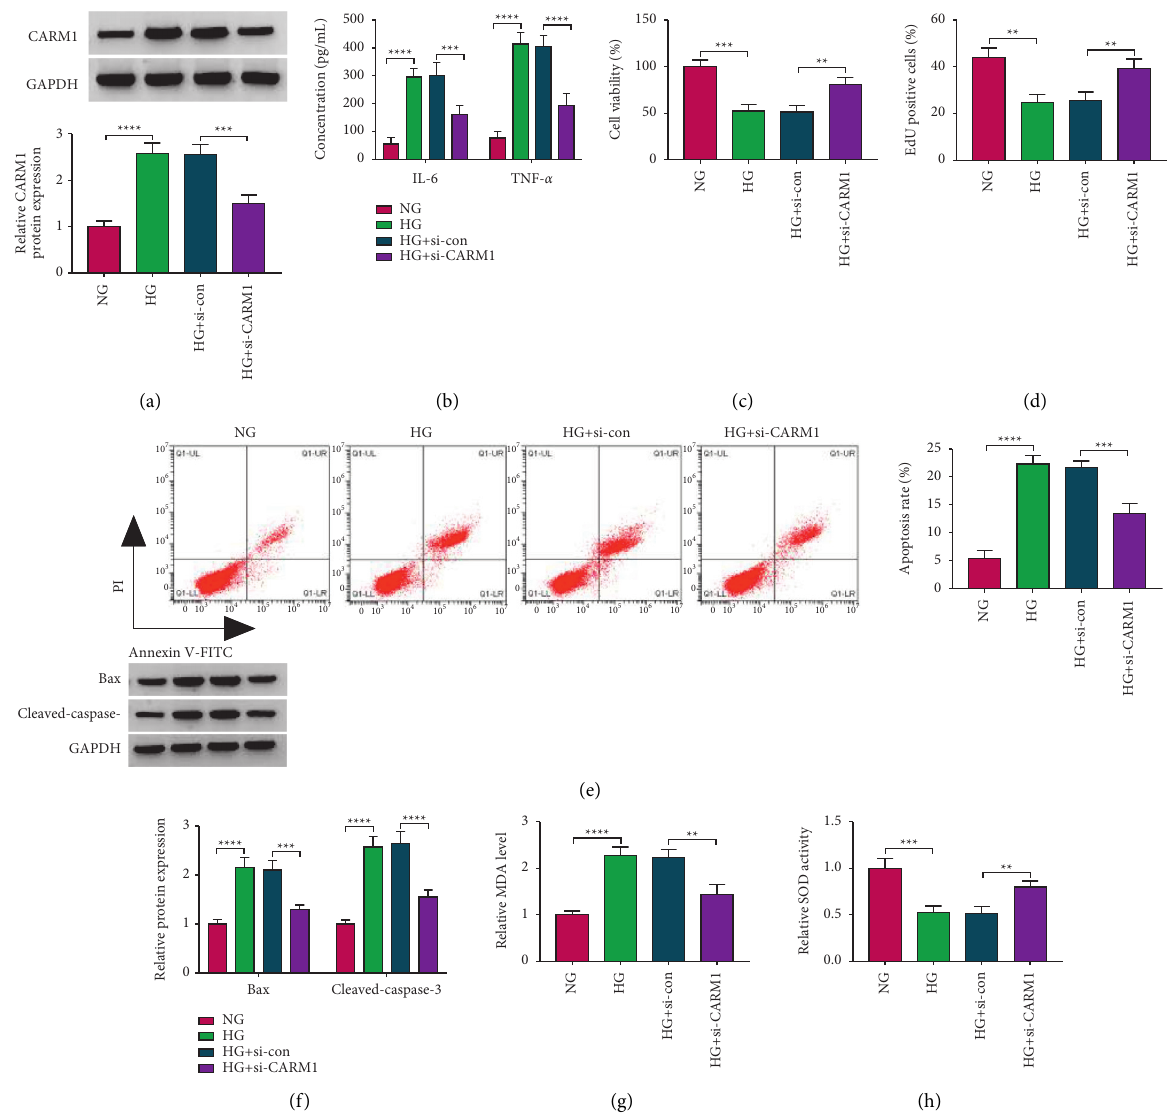
Figure 6: Effects of si-CARM1 on HG-induced ARPE-19 cell injury. ARPE-19 cells were transfected with si-con or si-CARM1 and then treated with HG. The cells treated with NG were used as control. (a) The protein expression of CARM1 was detected by the WB analysis. (b) ELISA was used to analyze the concentrations of IL-6 and TNF- α . Cell proliferation and apoptosis were determined using MTT assay (c), EdU assay (d), and flow cytometry (e). (f) The WB analysis was performed to examine the protein expression of Bax and cleaved-caspase-3. (g, h) Cell oxidative stress was analyzed by detecting MDA level and SOD activity. ∗∗ P < 0 . 01, ∗∗∗ P < 0 . 001, and ∗∗∗∗ P < 0 .